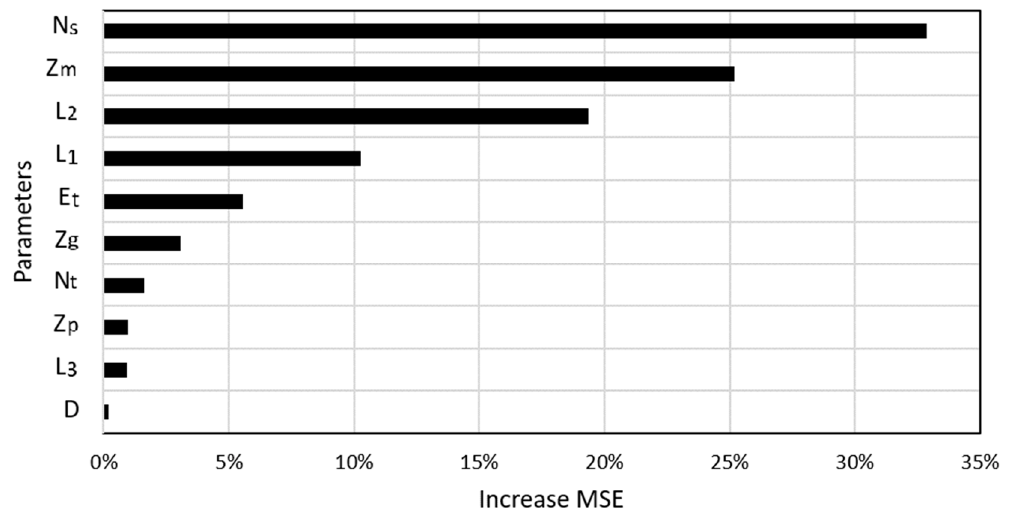
Figure 10. Feature importance of 10 variables used in this study.